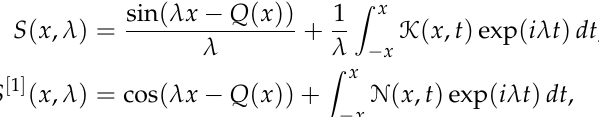
− 1 ( 0, π ) , j = 0, 1, from the 2